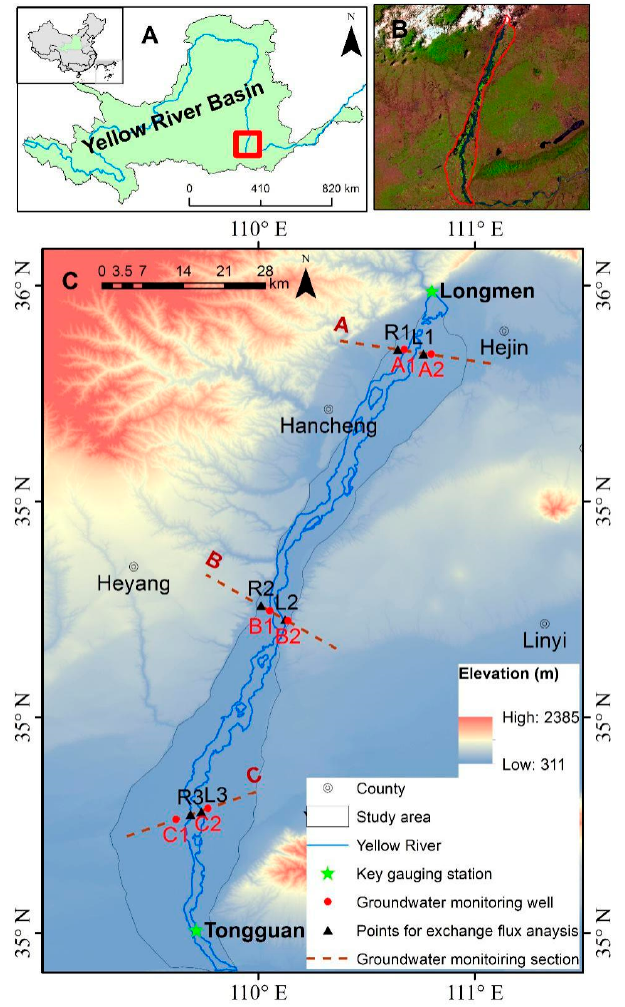
Figure 1. Location of the study area: ( A ) shows the geographic location of the study area within the Yellow River (marked in the red square); ( B ) is the close-up of the study area; and ( C ) shows the three groundwater monitoring transects that this study focused on.